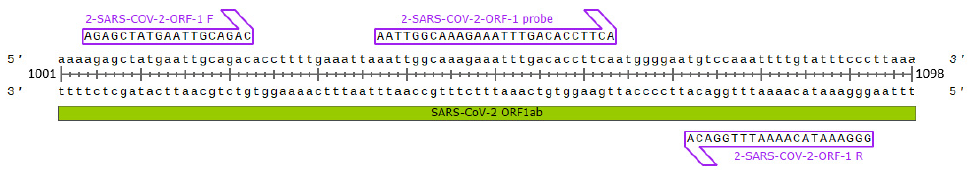
Figure 1. 2-SARS-CoV-2-ORF-1 oligonucleotides binding